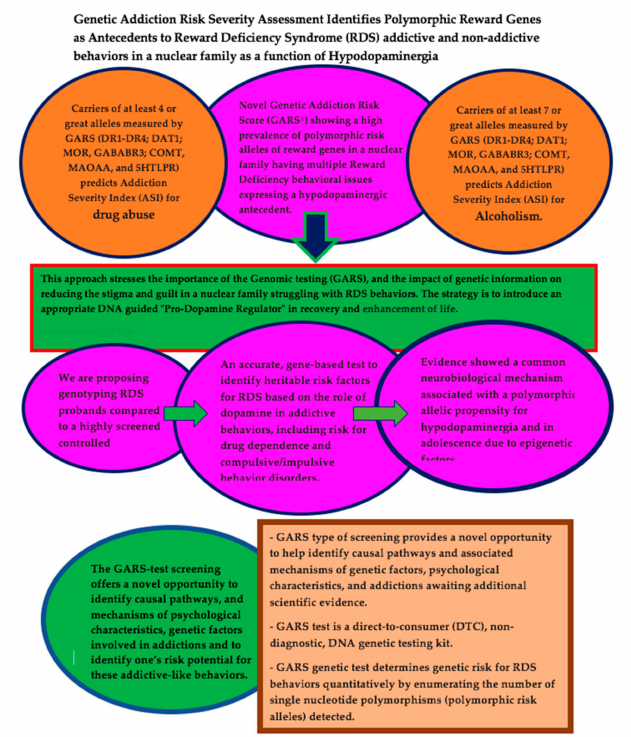
Figure 1. GARS assessment identifies polymorphic reward genes as antecedents to RDS addictive and non-addictive behaviors in a nuclear family as a function of